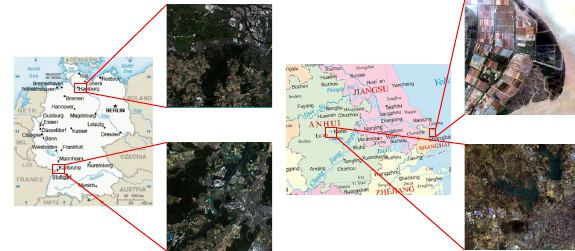
Figure 2. Images of the study